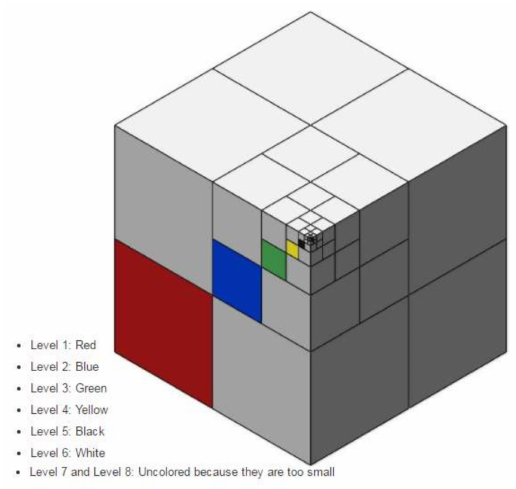
Figure 8. Different control volume size by different refinements levels [32].